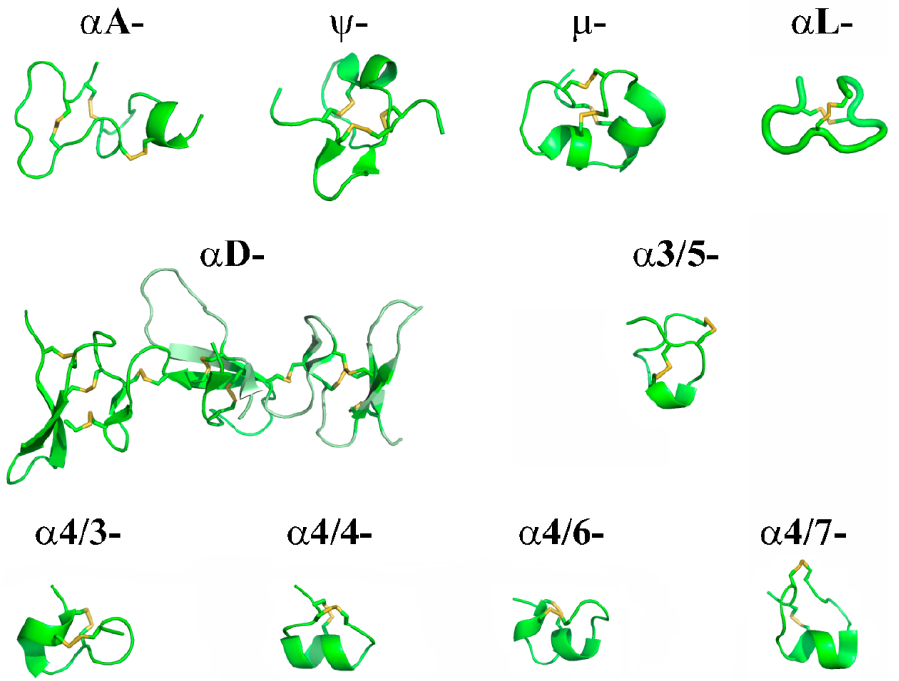
Figure 3. Ribbon visualization of NMR-structures of some representatives of families and groups of conotoxins targeting nAChRs α A-PIVA (PDB ID: 1PIP), ψ -PIIIE (1JLO), µ -CnIIIC (2YEN), α D-GeXXA (4X9Z), α L-lt14a (BMR ID: 21014), α 4/3- RgIA (2JUQ), α 3/5-CnIA (1B45), α 4/4-BuIA (2I28), α 4/6-TxID (taken from PDB presentation of molecular-dynamics simulation of the complex between TxID and the binding site of α 6 β 4 nAChR [106]), and α 4/7-Bt1.8 (2NAY). Yellow color indicates -S-S-bonds of disulfide bridges.